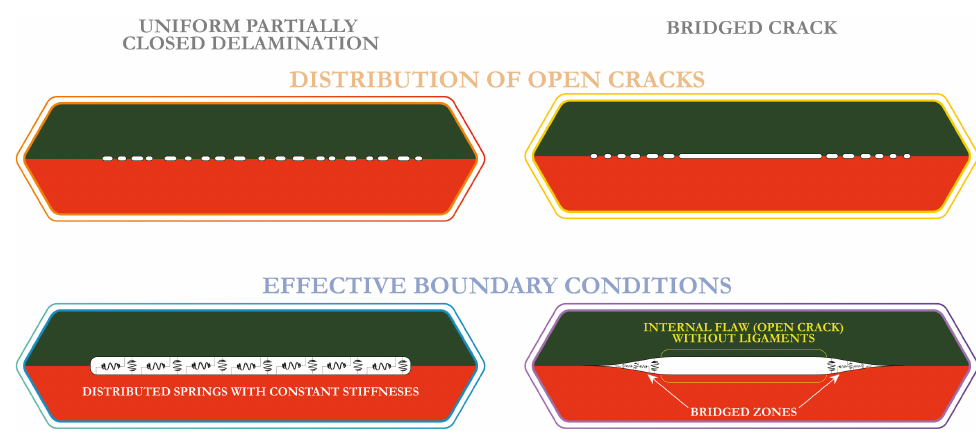
Figure 1. Different classes and mathematical models of delaminations considered in this